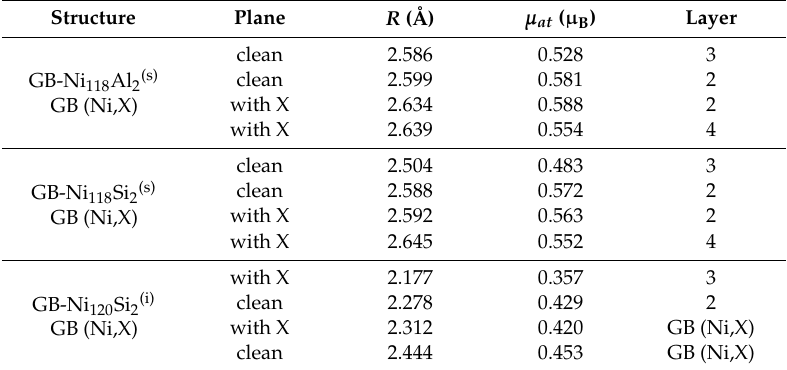
Table 5. Magnetic moment of Ni atoms µ at in the neighborhood of impurity X. R stands for the distance from